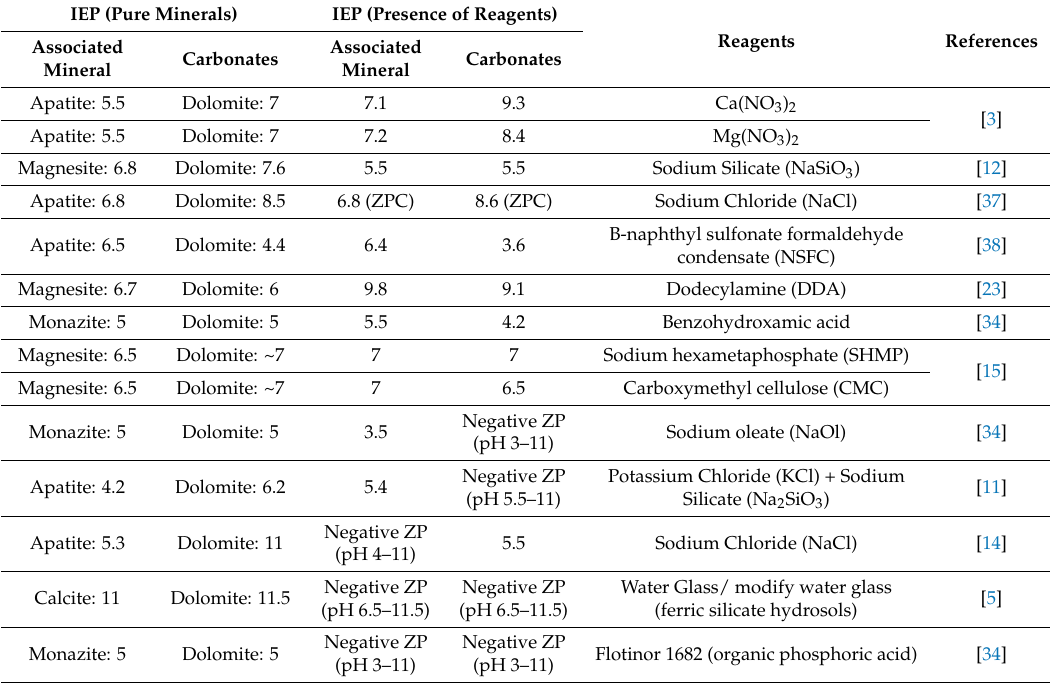
Table 2. The IEP of Mg carbonates in various